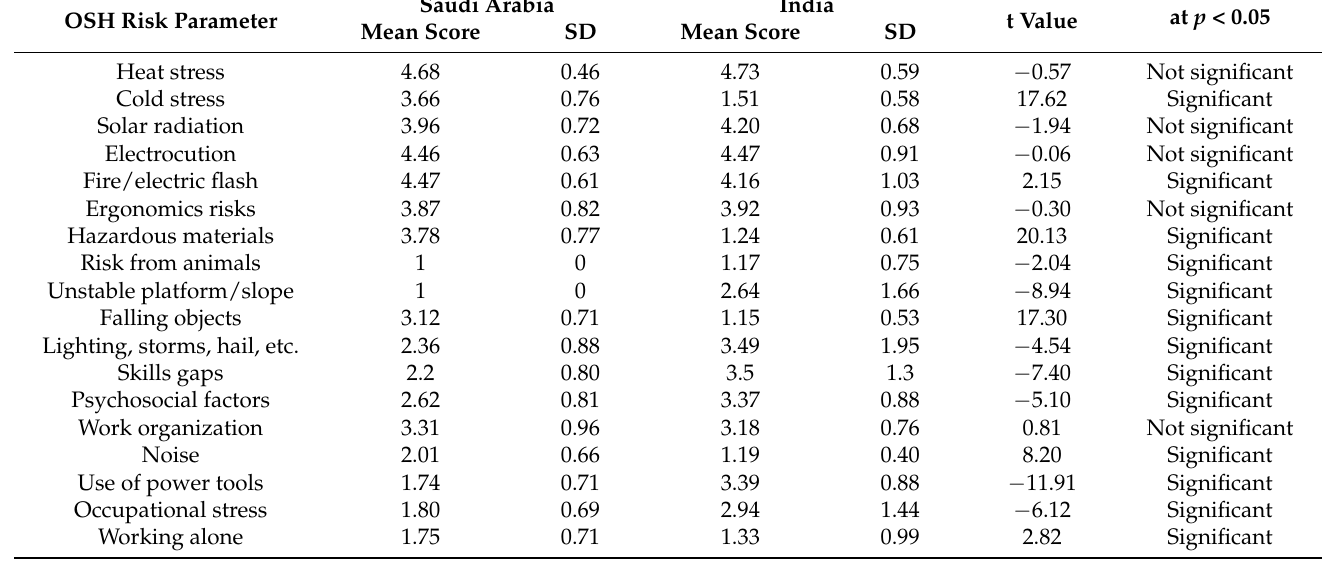
Table 3. Summary of the comparison of means between the two groups of workers .